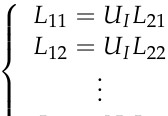
of the results of Equations (11)–(13).